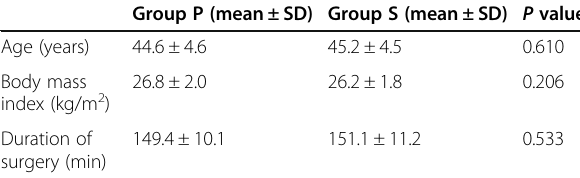
Table 1 Demographic data of both study